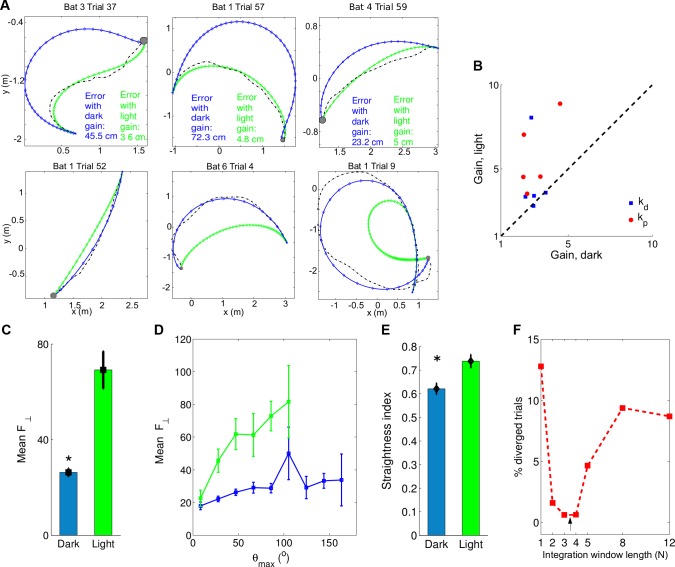
Effects of different sensory inputs (vision versus echolocation) on flight control.(a–c) Six example flights: three recorded in the light (top) and three in the dark (bottom, same examples as in Figs. 1–2). Dashed black curves, real trajectories. Blue curves, trajectory of PD controller using kd, kp gains optimized for dark conditions. Green curves, trajectory using kd, kp gains optimized for light conditions. Dots represent sensory acquisition time samples (Blue: 10 Hz, echolocation; Green: 25 Hz, vision). The errors between the real and simulated trajectories (indicated inside the figures) show that high gains are preferable in light conditions. (b) Gain parameters of the PD controller in light and dark for each bat (for the five bats that participated in both dark and light experiments). Note that eight of the ten parameters were above the diagonal—indicating larger gain parameters in light versus dark. (c) The forces exerted by the simulated bat (F
⊥) were much stronger in the light than in the dark (see main text). (d) The mean force exerted by the simulated bats increased with the maximum angle θ
max in both light and dark, but was always stronger for light (green) than for dark conditions (blue). (e) The straightness index of the real bat trajectories (see Materials and Methods) was significantly lower in dark than in light, for initial angles > 45° (p < 0.03); this indicates that the bat flies straighter in light conditions. (f) An integration window of length 3 yielded simulations that reconstructed most accurately the real flight trajectories in the light (arrow). All the data is available in the S3 Data.